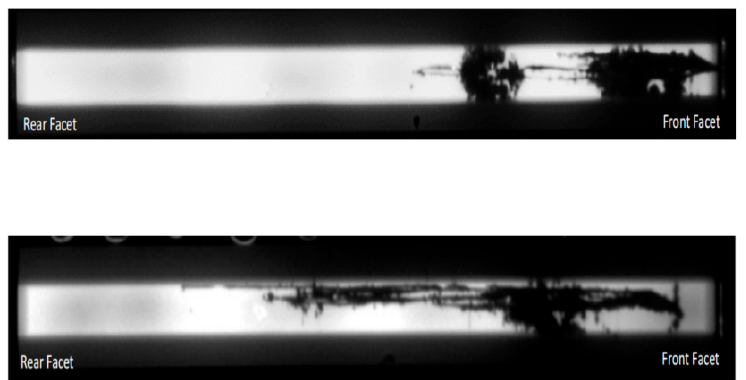
Figure 10. EL images of degraded multi-mode lasers show a facet failure and a bulk failure [68]. Reprinted with permission from ref. [68] © Springer Nature. Copyright 2018 MRS Advances.